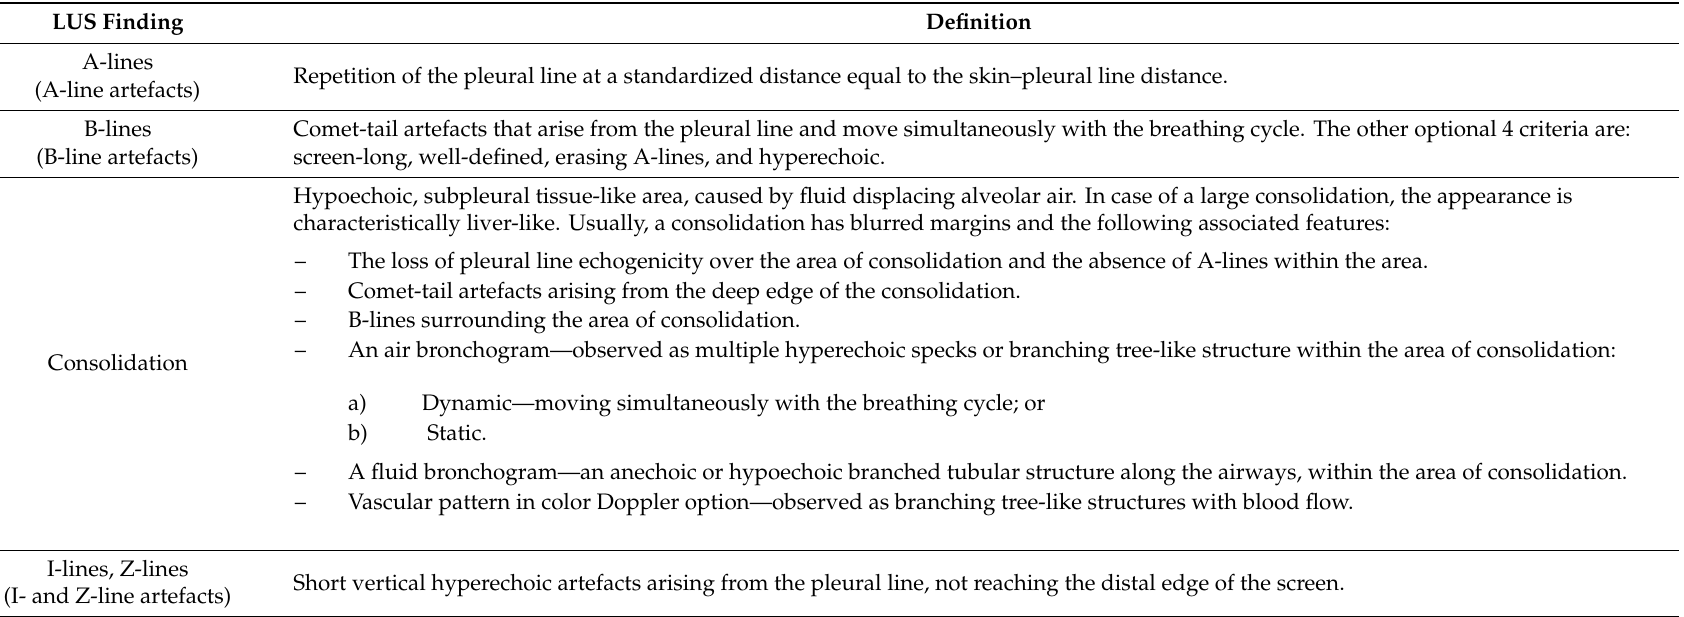
Table 4. Basic definitions of lung ultrasound (LUS)